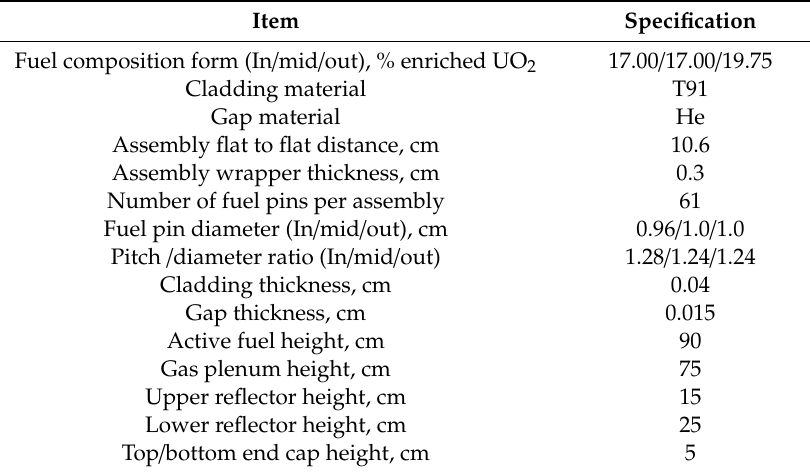
Table 2. Design parameters of the fuel assemblies.